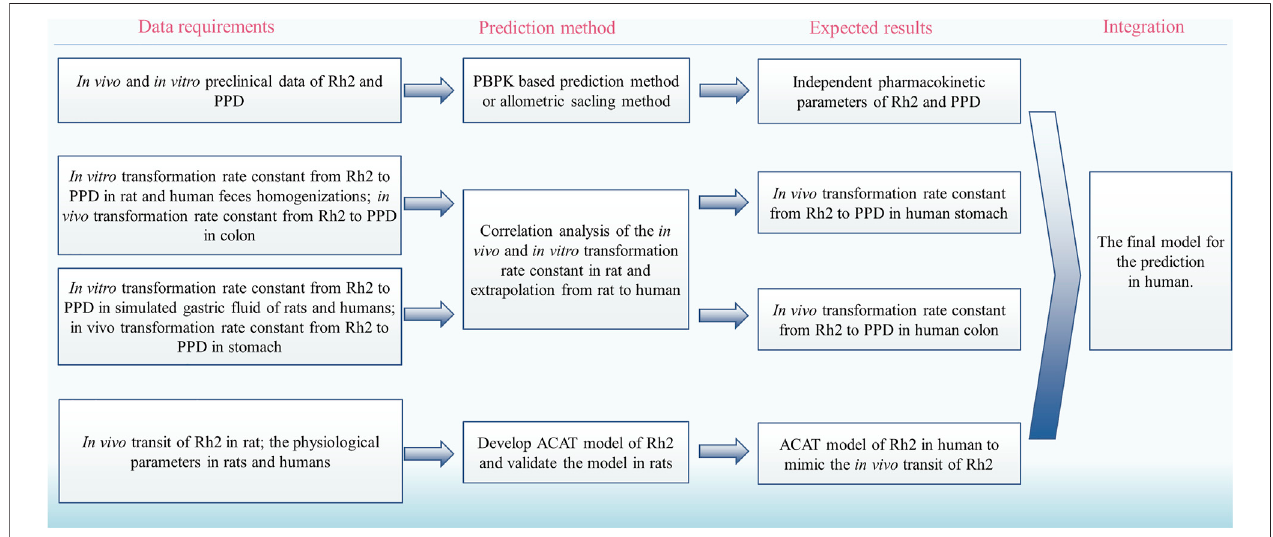
FIGURE 4 | The proposed strategy to translate the deglycosylation kinetics from rats to humans. PBPK, physiologically based pharmacokinetic; ACAT, advanced compartmental absorption and